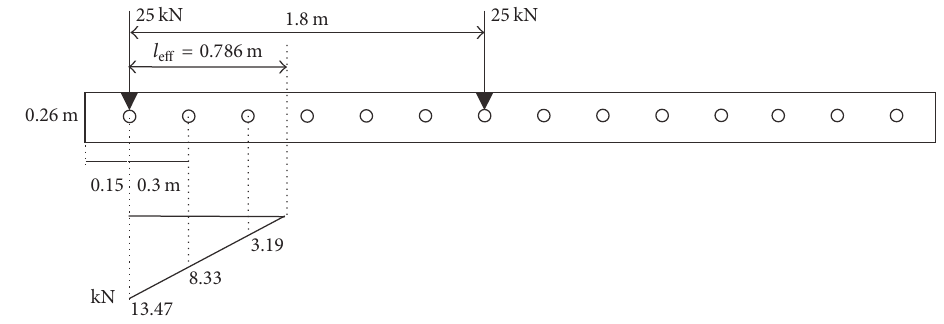
Figure 1: Load diagram at pavement joint.